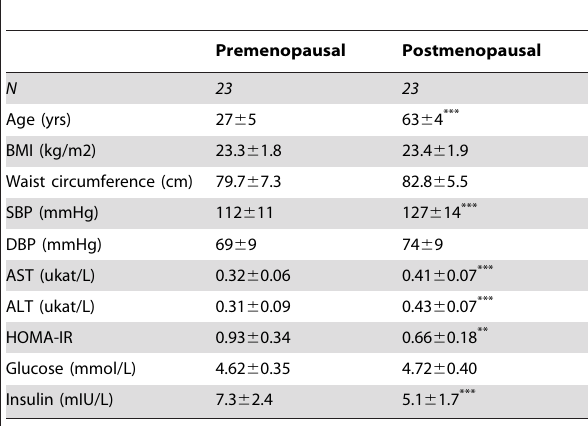
Table 1. Subject